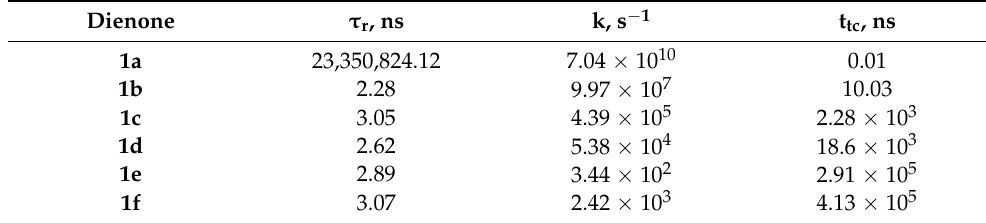
Table 7. Radiative lifetime of the ( E , E ) isomer, E - Z isomerization rate constant and time. Dienone